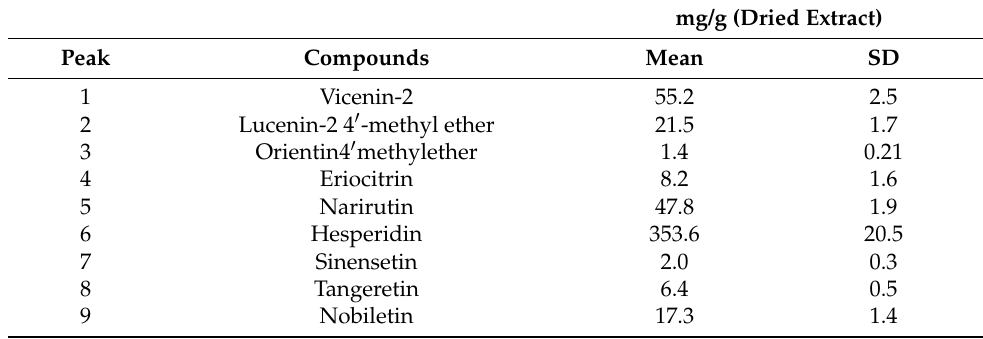
Table 2. Quantitative determination of the identified compounds.